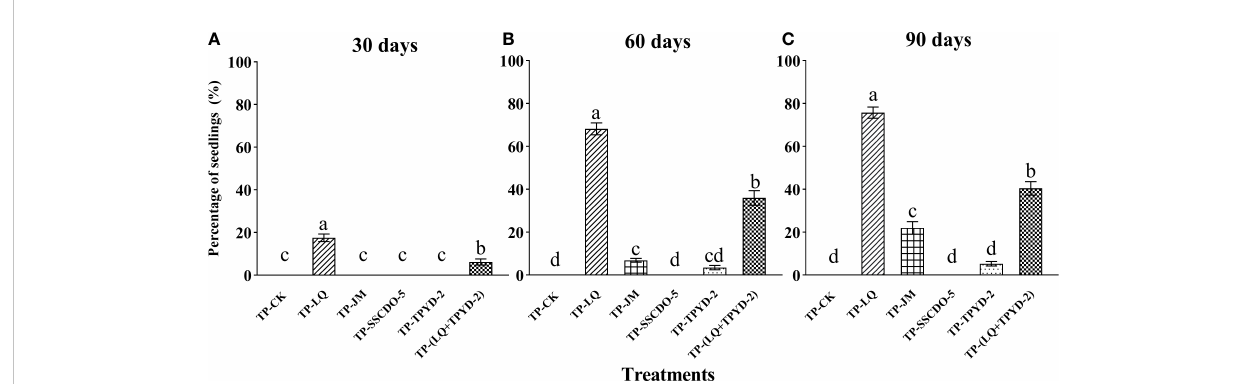
FIGURE 2 The percentages of seedlings (mean±SE) in the control (TP-CK) and fi ve fungal treatments (LQ, JM, SSCDO-5, TPYD-2, and LQ+TPYD-2) of seedfungus complexes of Dendrobium of fi cinale at (A) 30, (B) 60, and (C) 90 days after sowing. In each panel, different letters indicate signi fi cant differences ( p < 0.05) based on one-way ANOVA and the least signi fi cant difference ( LSD ) method where the data are normally distributed and the generalized linear model ( GLM ) where the data are not normally